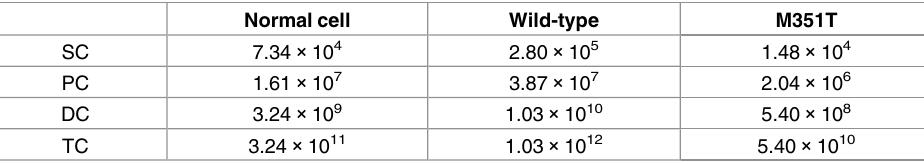
Table 2. The initial cell